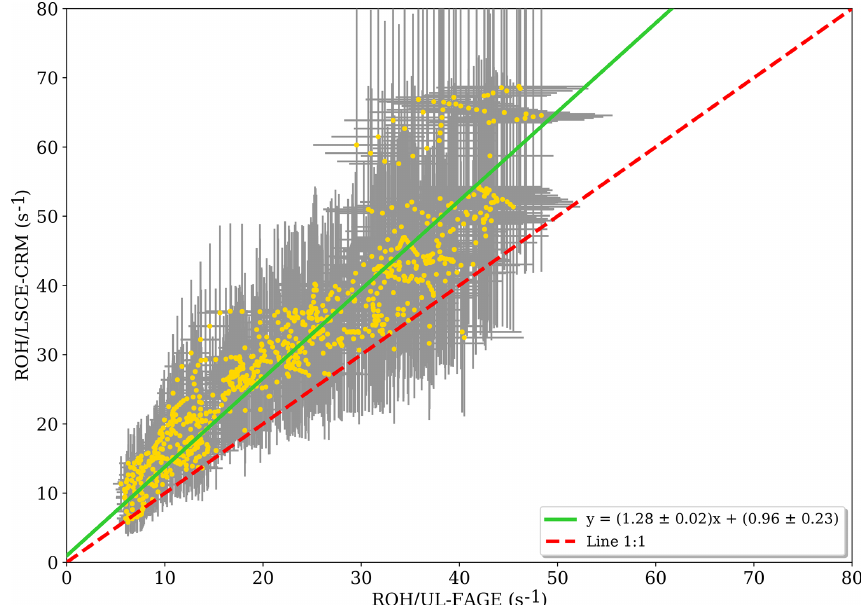
Figure 3. Measured reactivity by the LSCE-CRM instrument as a function of the measured reactivity by UL-FAGE when both instruments were measuring at the same location within the canopy (data resampled with a time resolution of 1min). Errors bars represent the overall systematic uncertainty (1 σ ) that is around 15% and 35% for LP-LIF and the CRM,